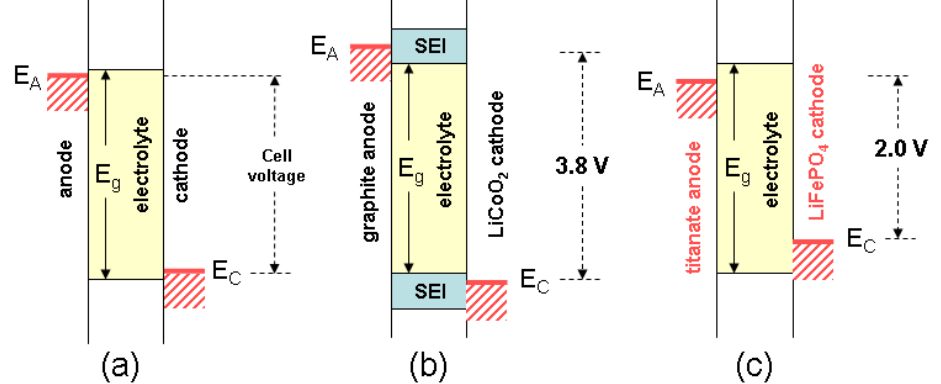
Figure 12. Schematic comparison between the LCO//graphite and the LFP//LTO cells. ( a ) Ideal battery where potential E − E < E , the voltage of the battery is equal to the A C g − E ; ( b ) The conventional graphite//LiCoO energy difference V = E C A E − E > E ; this cell works through the formation of the SEI; ( c ) The HQ-type LTO//LFP A C g − E < E ; this cell operates without the formation of the Li-ion battery where E A C g